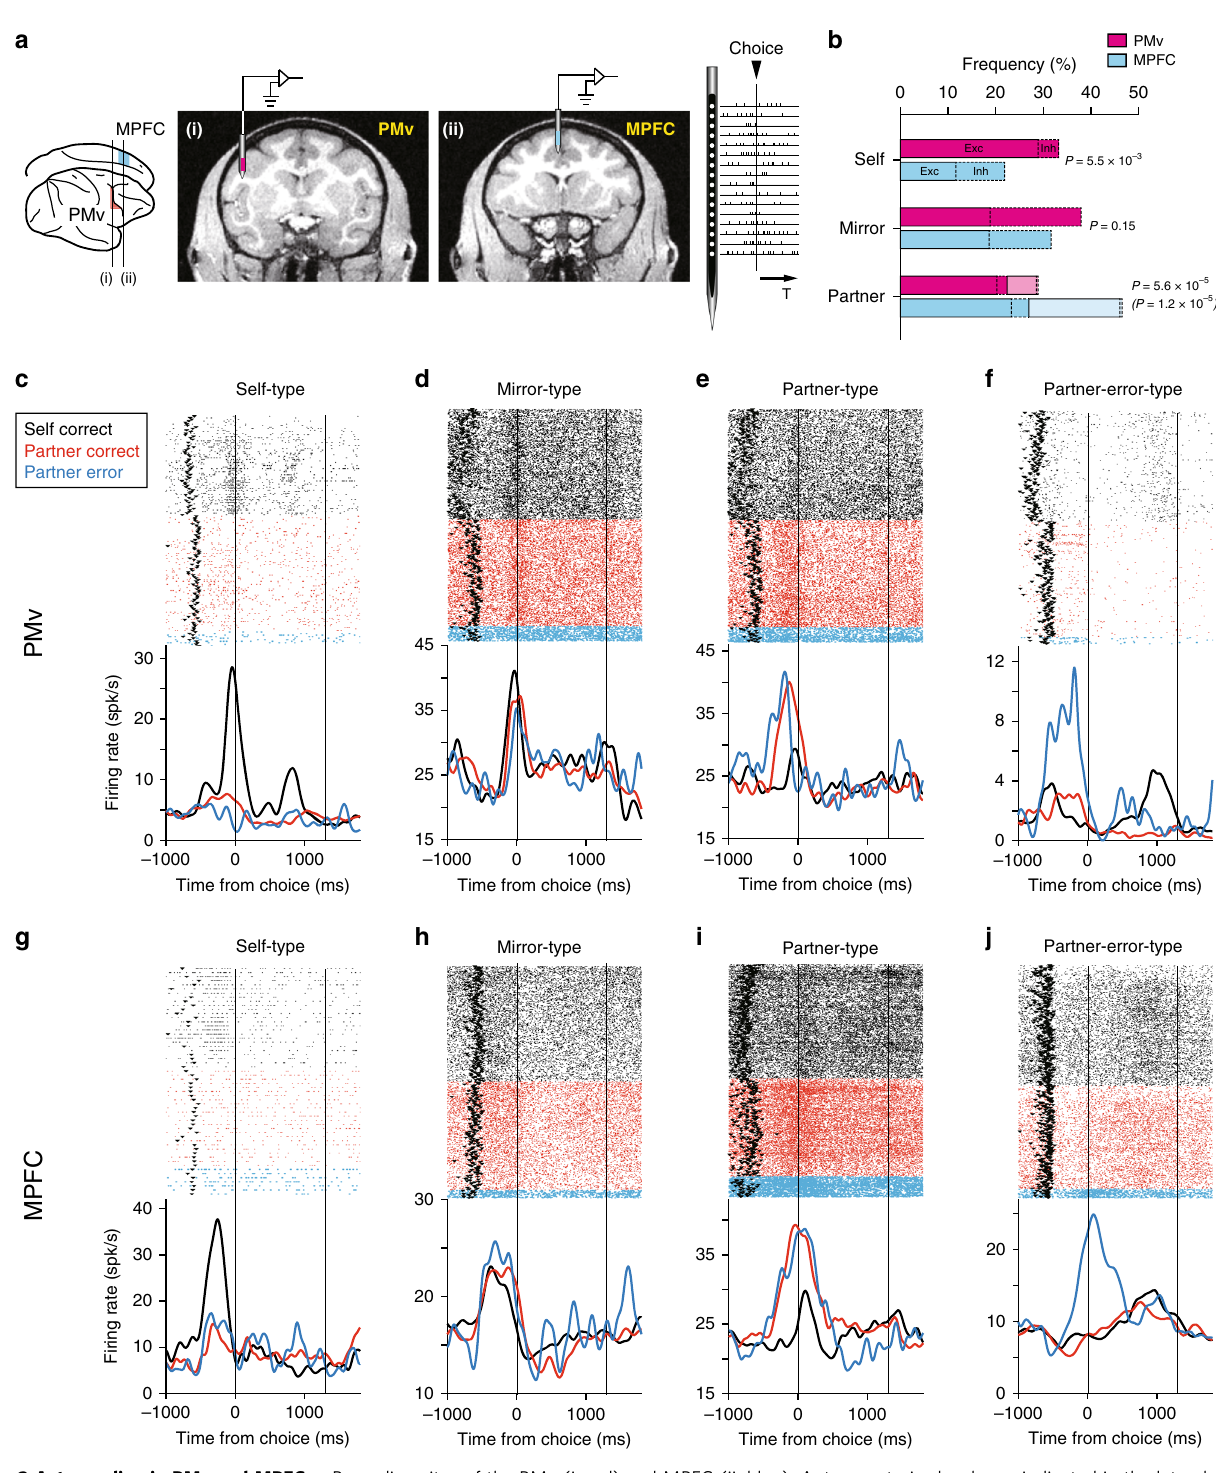
Fig. 2 Actor coding in PMv and MPFC. a Recording sites of the PMv (i, red) and MPFC (ii, blue). Anteroposterior levels are indicated in the lateral view (left). Single-unit activities were recorded simultaneously in the two areas using two 16-channel electrodes. b Proportions of each neuronal type in the PMv (red) and MPFC (blue) in the RA condition. Bars with solid lines, excitatory type; bars with dashed lines; inhibitory type. P values, χ 2 test (two-sided). Light- colored bars depict proportions of partner-error-type neurons ( P value in parenthesis). c – j Raster displays and spike-density functions aligned to the time of target button press ( ‘ Choice ’ in Fig. 1a) for PMv neurons ( c – f ) and MPFC neurons ( g – j ). Self-type neurons ( c , g ), mirror-type neurons ( d , h ), partner-type neurons ( e , i ), and partner-error-type neurons ( f , j ). Colored small dots and black triangles in raster displays indicate the times of individual action potentials and target onset ( ‘ Target on ’ in Fig. 1a), respectively. Vertical lines at 1300 ms indicate the time of reward